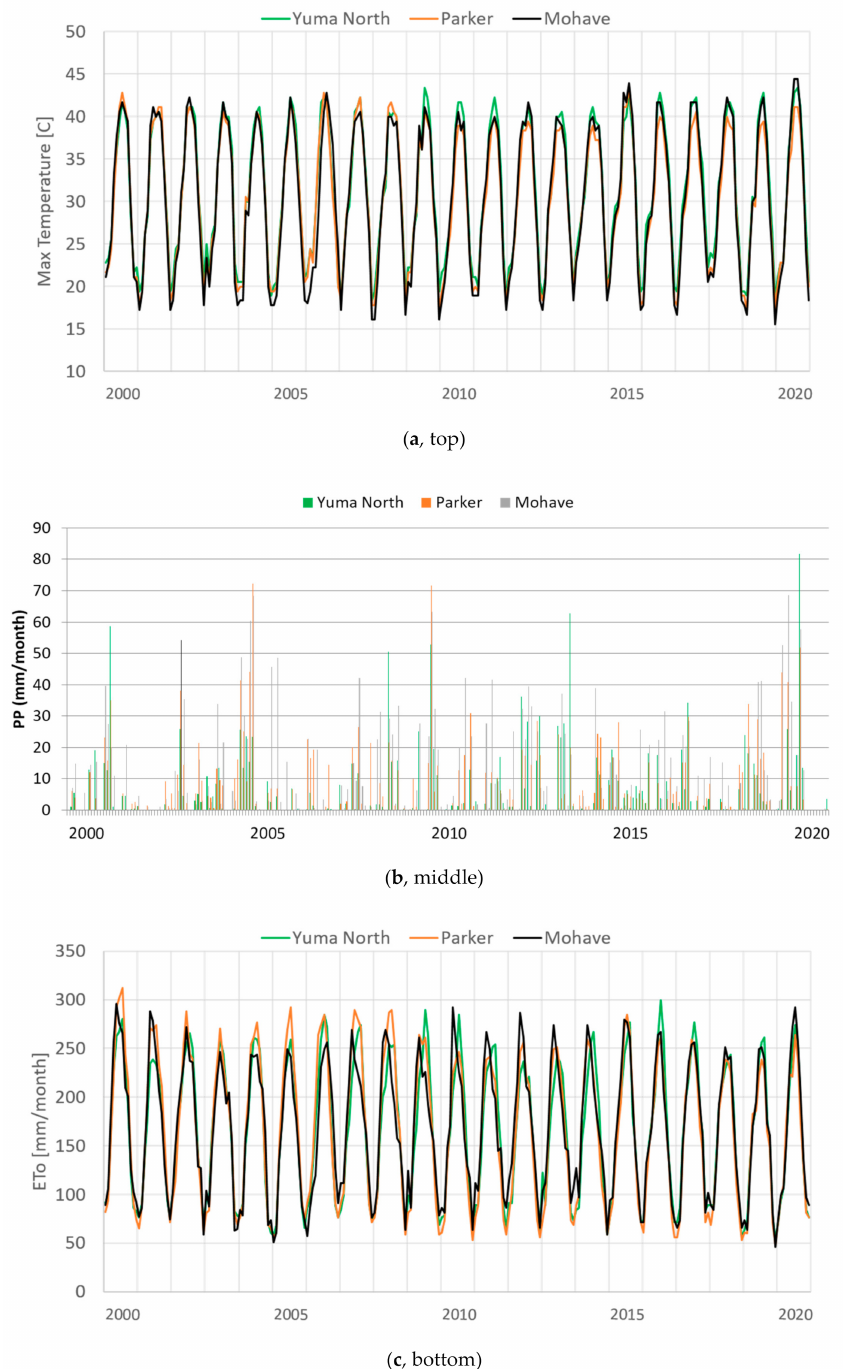
Figure 2. Weather variables from three Arizona Meteorological Network (AZMET) stations (https://cals.arizona.edu/azmet/, accessed on 24 February 2021) located from north to south along the Lower Colorado River (Mohave, Parker, Yuma North Gila) showing 21 years of data plotted for maximum air temperature ( a , top ), precipitation ( b , middle ), and ET o ( c , bottom